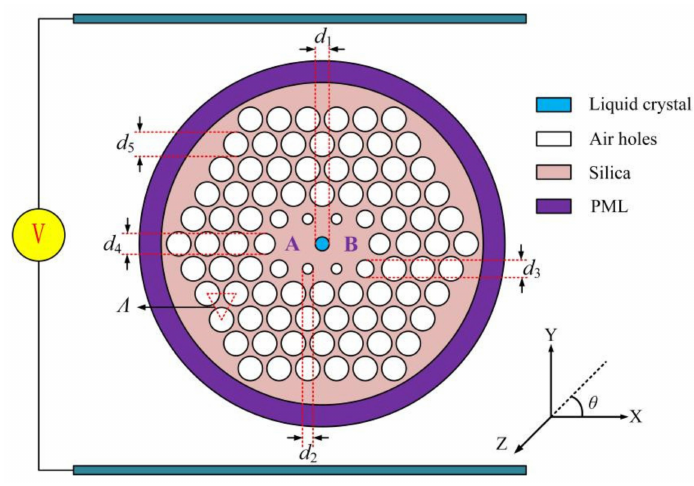
Figure 1. The cross-sectional structure of the proposed LC-DC-PCF